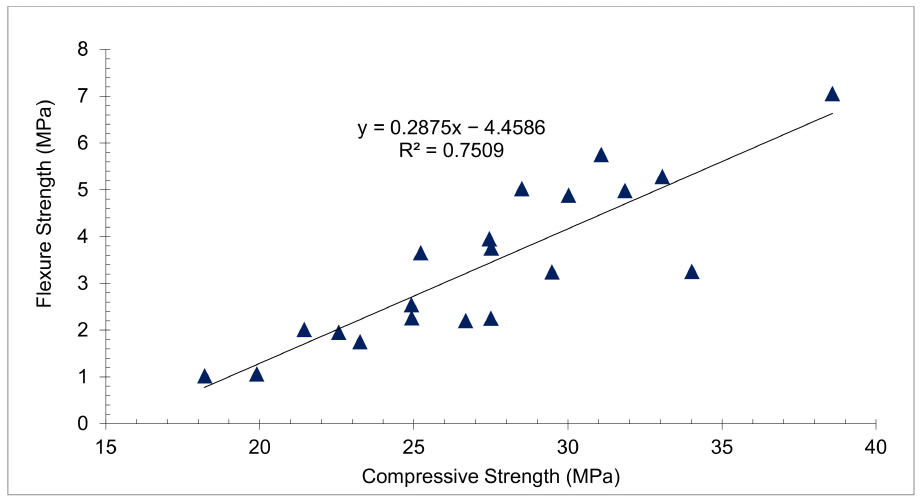
Figure 6. Linear Regression between Compressive and Flexural Strength: Data Source